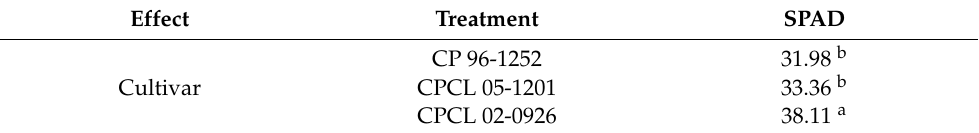
Table 4. Mean SPAD in different sugarcane cultivars in first greenhouse experiment a .